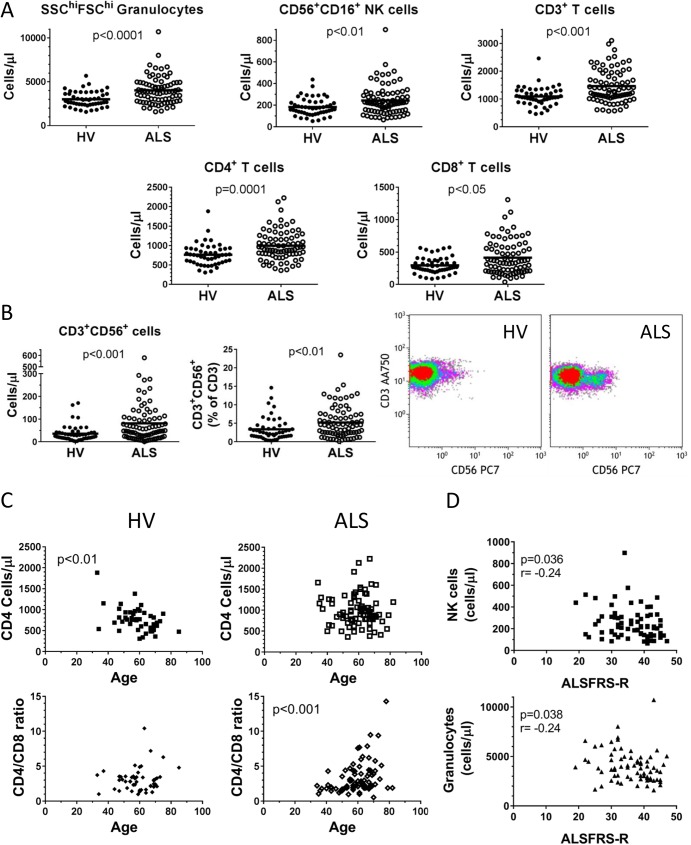
ALS patients exhibit elevated cell counts of granulocytes, NK cells and T cells.Major leukocyte populations from 80 ALS patients and 50 healthy volunteers were assessed by flow cytometry. A. Comparisons of granulocytes, NK cells, T cells, CD4+ T cells, and CD8+ T cells between healthy volunteers (dark circles), and ALS patients (open circles). B. CD3+CD56+ T cells shown as cell counts (cells/μl), percentage of total T cells, and a representative dot plot. C. Correlations of CD4+ T cells and CD4:CD8 ratios are altered in ALS patients. D. NK cells and granulocyte counts inversely correlate with ALSFRS-R score.